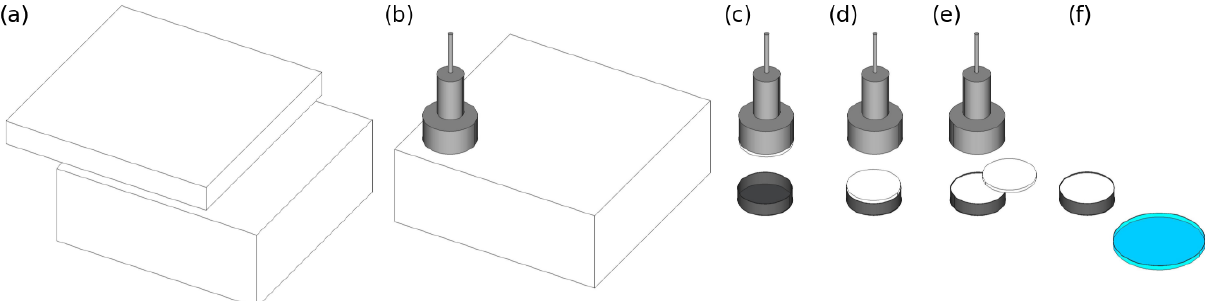
Figure 4. Step-by-step illustration of the sampling procedure. (a) Within each snow block (snow types A, B, C and D), we identified a homogeneous layer of snow with SMP measurements. We removed the unsuitable material above the sampling layer with a saw. Afterwards, we gently brushed the surface to remove loose particles from the sawing process. Panel (b) presents the IC sample extraction with the IC sampling device (piston). The snow sample is 35mm thick. Panel (c) outlines the transfer of the snow sample into the IC sampling holder, which has a height of 30mm. Panel (d) shows the transferred snow sample with 5mm of protruding snow. (e) We cut off the protruding snow with a sharp spatula (the sample is slightly tilted), following Gallet et al. (2009), and performed the first IC measurement (IC + particles). (f) We tilted the IC sampling holder above a Petri dish (blue) to collect the remaining loose particles, created during the sampling step shown in panel (e) , for further analysis (macro-photographs and particle weight), and the sample was measured again with the IC (IC − particles).